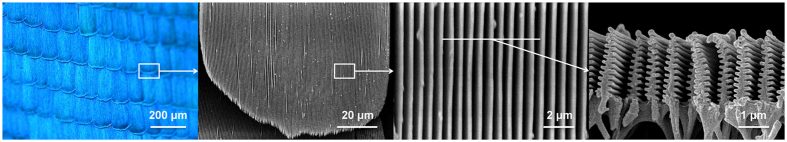
Images of Morpho Rhetenor.An optical microscope image (far left) and three scanning electron microscope (SEM) images of a Morpho Rhetenor butterfly, showing the structure in increasing detail.